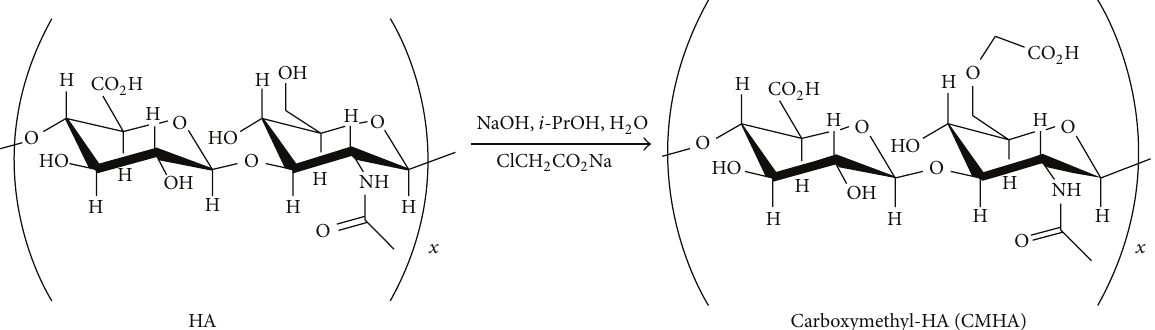
Figure 1: Chemical modification of hyaluronan (HA) to carboxymethyl hyaluronan (CMHA). HA was chemically modified to produce CMHA in a basic solution which modifies approximately 15–20% of the 6 󸀠 -OH groups of the N-acetylglucosamine residues. This process reduces the molecular weight and introduces additional carboxyl groups for stabilization of